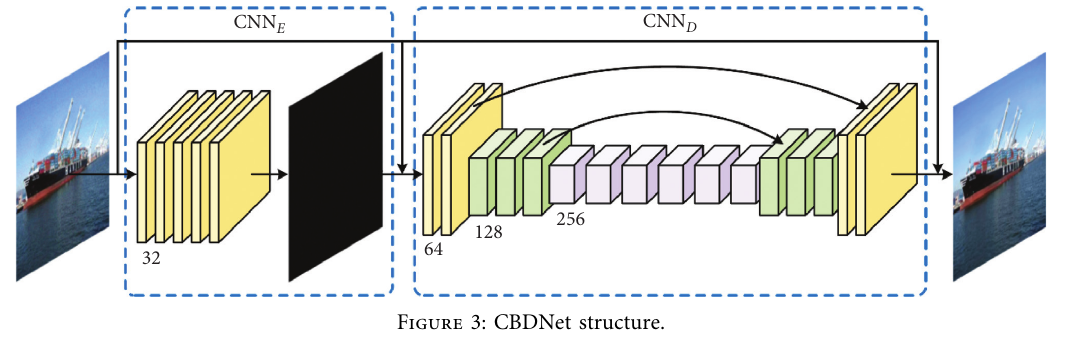
Figure 3: CBDNet structure.